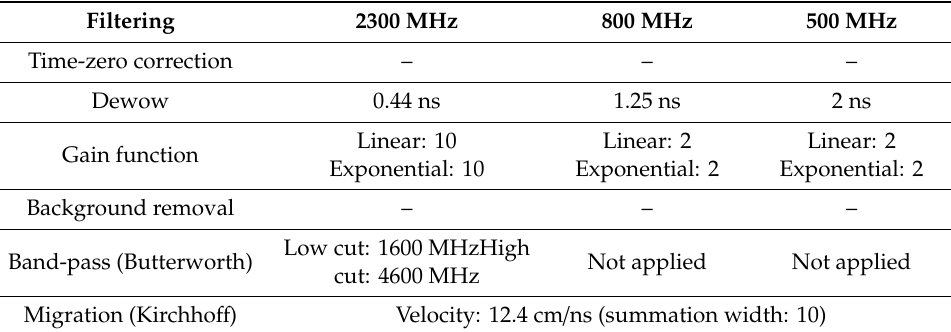
Table 2. Filters and parameters used for GPR data